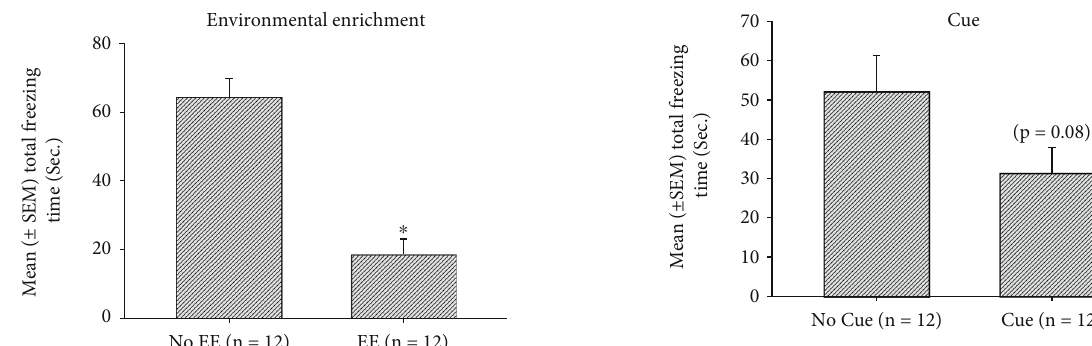
Figure 3: Assessments of mean ( ± SEM) total freezing time (Sec.) for the main e ff ect of the cue in the no cue ( n = 12 ) and cue ( n = 12 ) conditions. ∗ p < 0 : 05 indicates signi fi cant di ff erences compared to the no cue